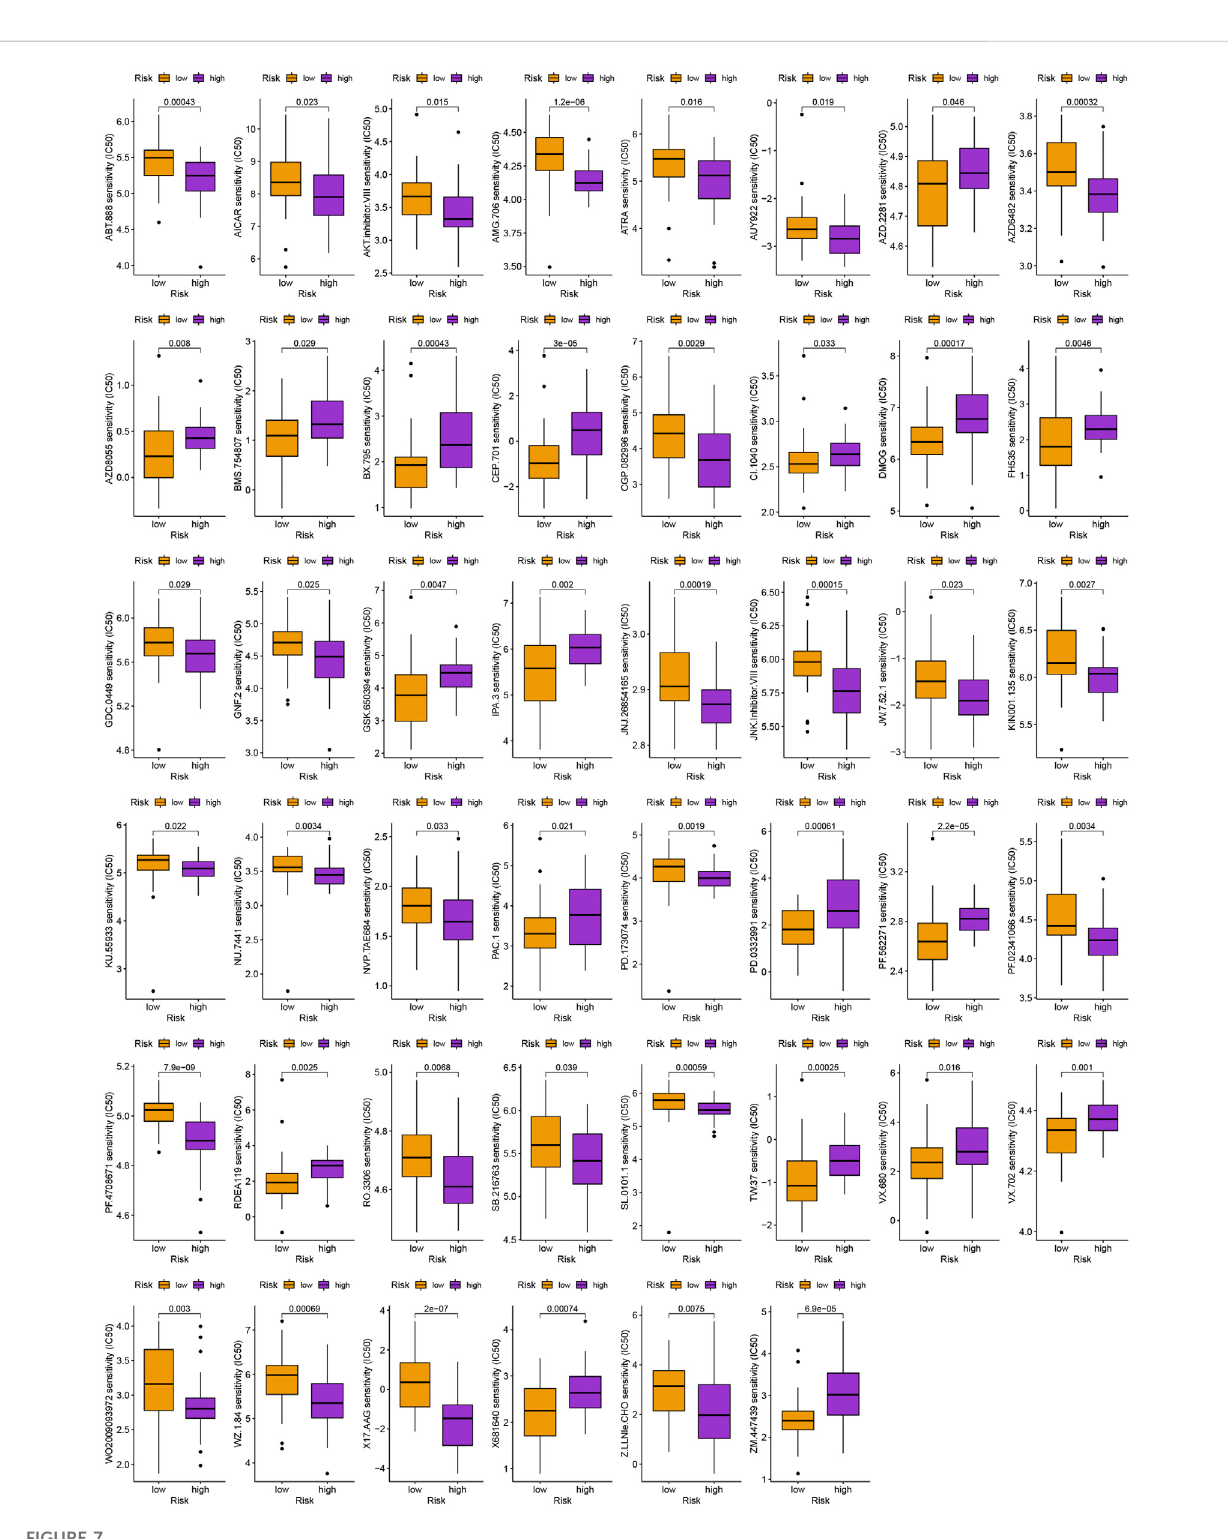
FIGURE 7 Schematic representation of novel potential agents for uveal